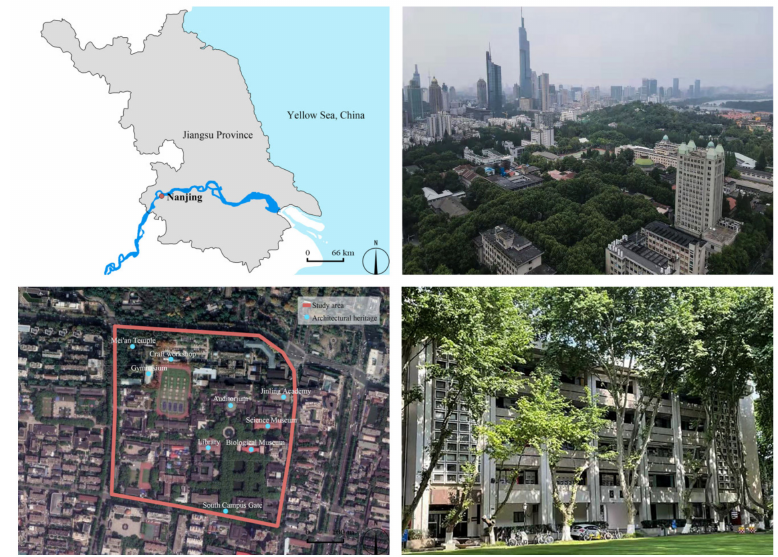
Figure 2. SEU within China and Nanjing: location of case area and information on architectural heritage.